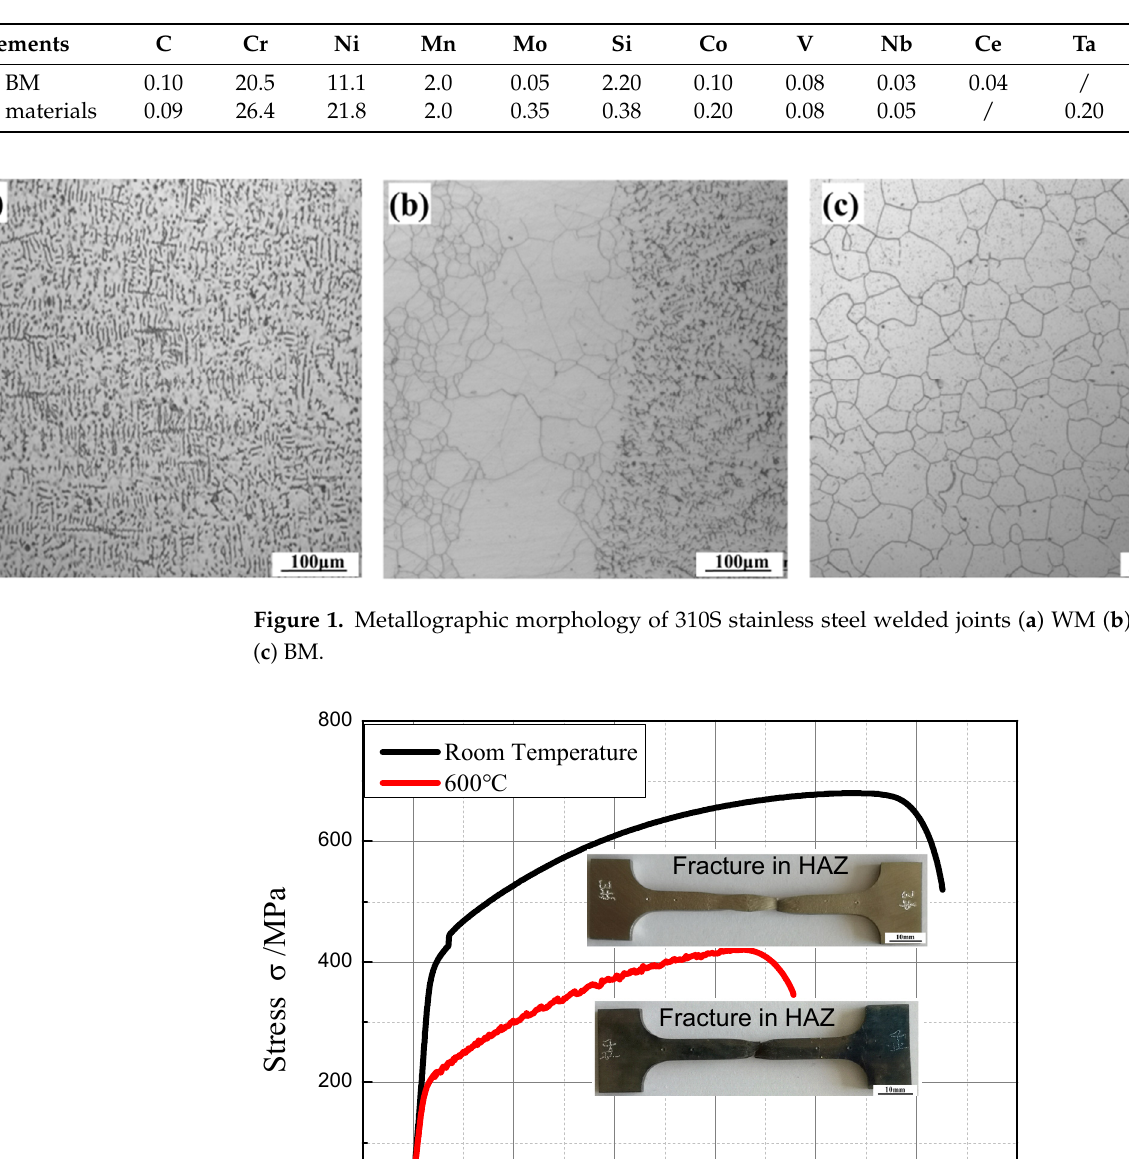
Table 1. The main chemical compositions of BM and filler materials (wt.%).